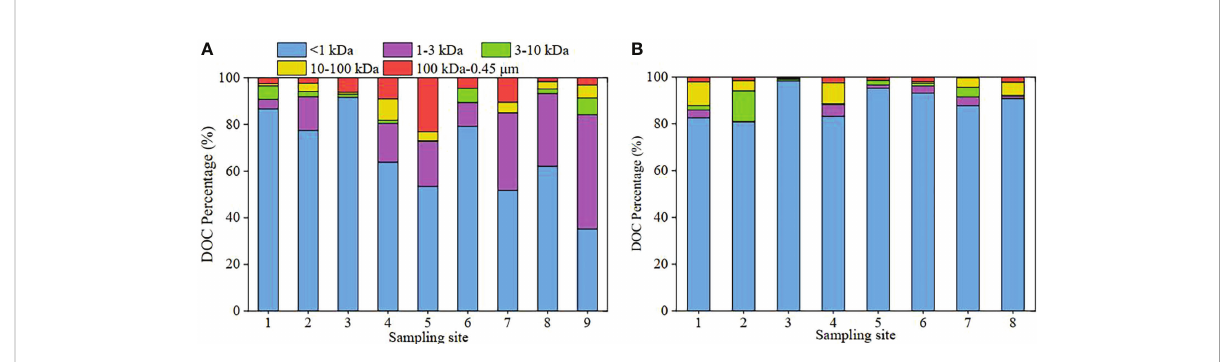
FIGURE 3 Percentage distribution of DOC at different sites in surface waters of the Yellow River Estuary in spring (A) and autumn (B)